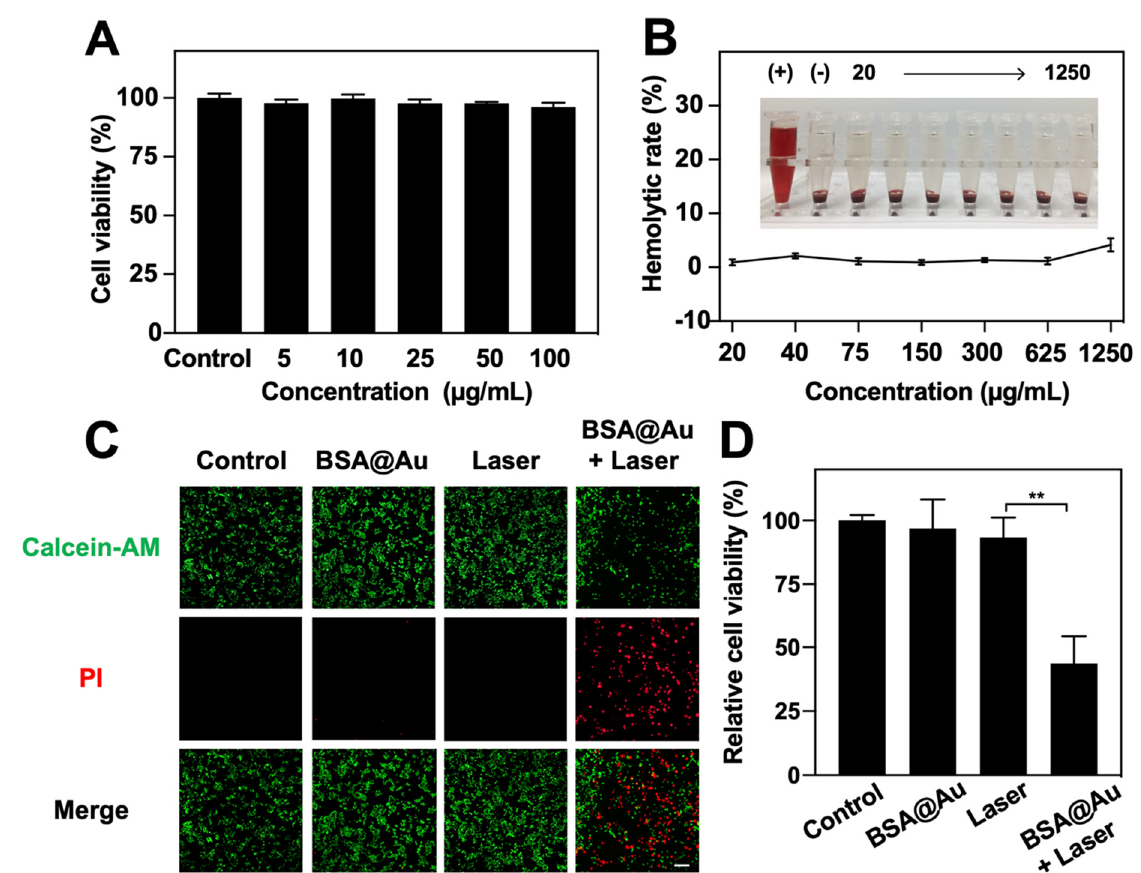
Figure 3. Cytotoxicity and in vitro anti-tumor PDT. ( A ) Cytotoxicity evaluation on 4T1 cells incubated with BSA@Au. ( B ) Hemolytic assay of BSA@Au on red blood cells (RBCs) from Balb/C mice. (+) represented RBCs solution mixed with ultrapure water; ( − ) indicated RBCs solution mixed with PBS. ( C ) Live/dead 4T1 cells visualization post PDT. The scale bar was 100 µm. ( D ) 4T1 cells viability post PDT. ** p < 0.01.